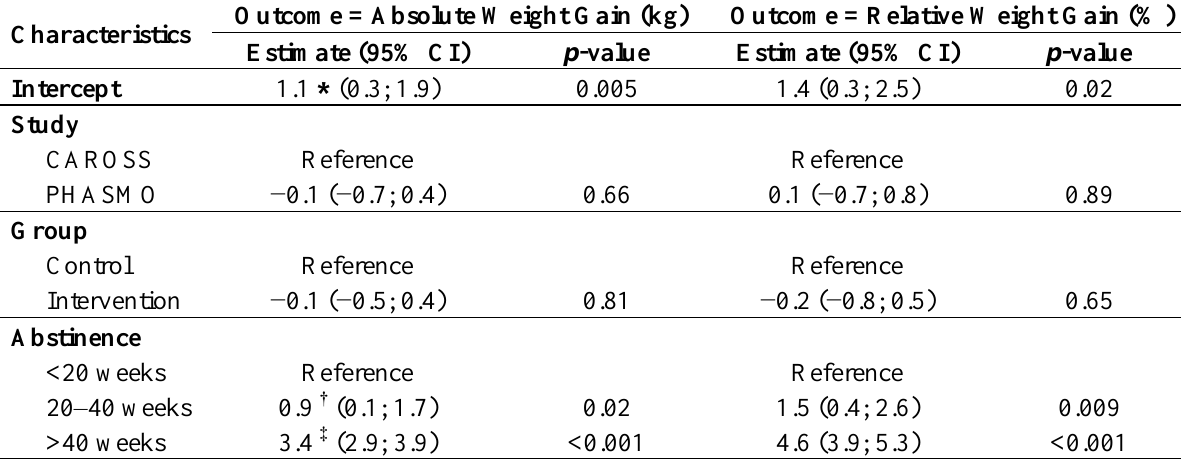
Table 3. Adjusted linear regression model of absolute and relative weight gain ( R 2 =